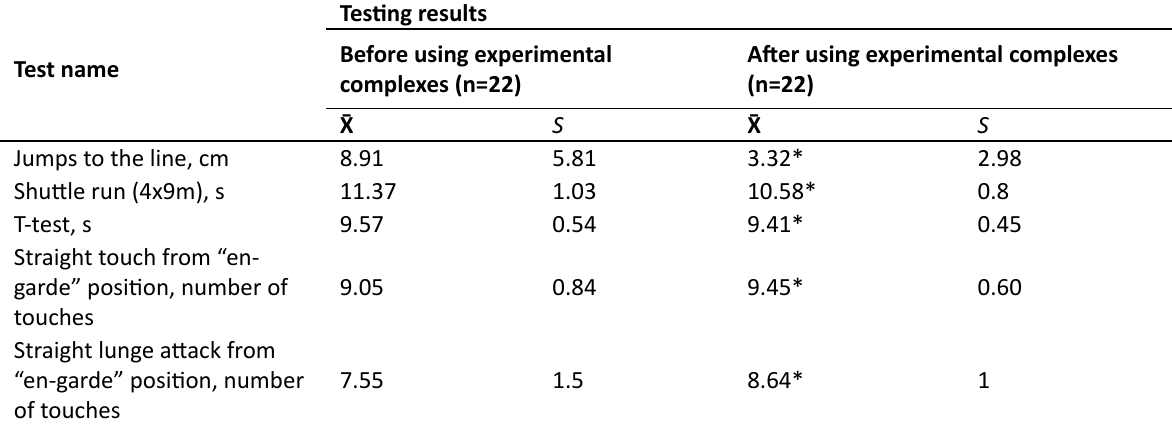
Table 1. The indicators of manifestation of the athletes’ coordination abilities before and after using experimental training